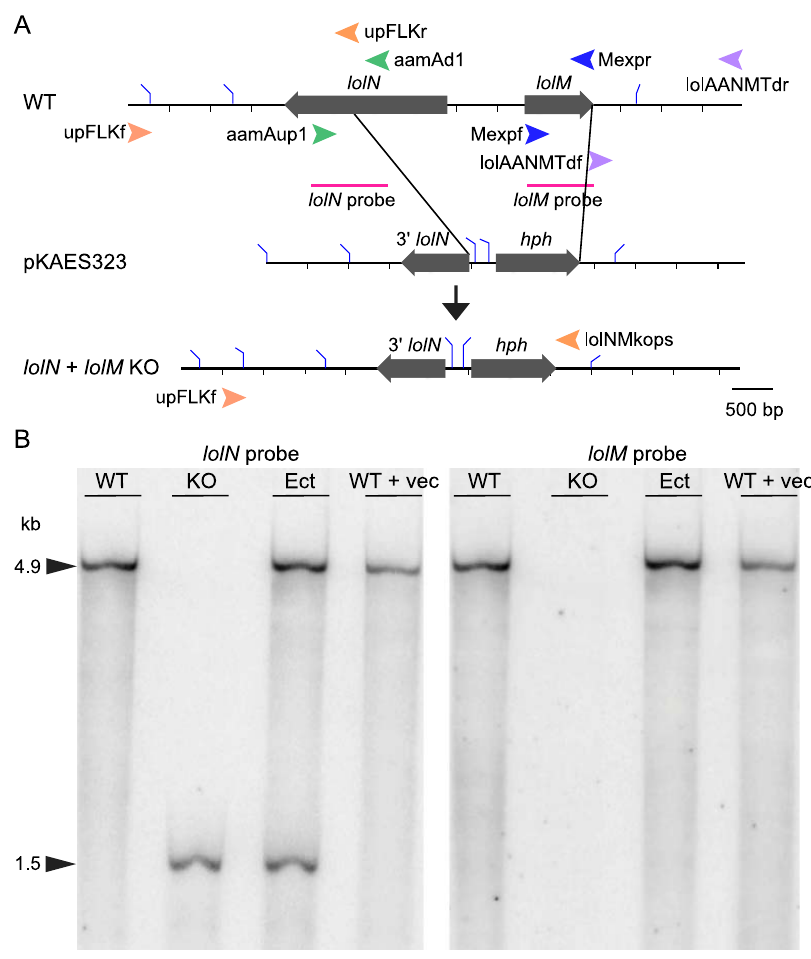
Fig. 3. Replacement of lolN and lolM with hph maker gene. (A) Schematic representation of lolN - lolM replacement by the hph marker gene via homologous recombination. Shown are maps of the wild-type lolN and lolM in Epichloe¨ festucae E2368 (WT), targeting vector (pKAES323), and the locus after homologous recombination (KO). Black bars represent DNA sequence, and filled arrows represent genes. Bent blue lines on the bars represent Hin dIII digestion sites. Colored arrowheads represent primers used to generate pKAES323 and to screen the transformants. (B) Southern-blot analysis of E. festucae strains. Wild-type E2368 and transformants were probed with a lolN fragment or lolM gene amplified from E2368 (old probe was stripped off the membrane before new hybridization). Lanes contained Hin dIII-digested genomic DNA from E2368 (WT), lolN - lolM knockout transformant (KO), ectopic transformant of E2368 with pKAES323 (Ect), and E2368 transformed with the empty vector pKAES173 (WT +